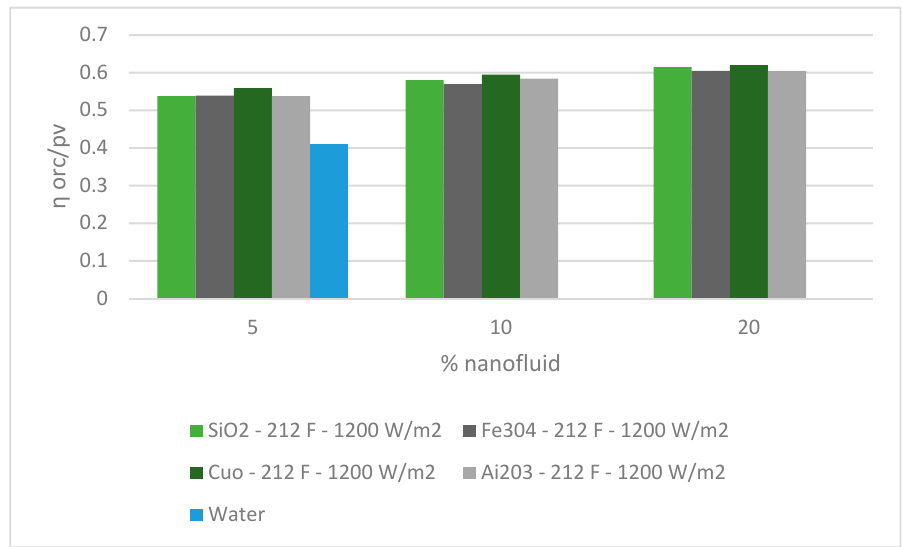
Figure 17. Hybrid system efficiency for different nanofluids at 194 °F .